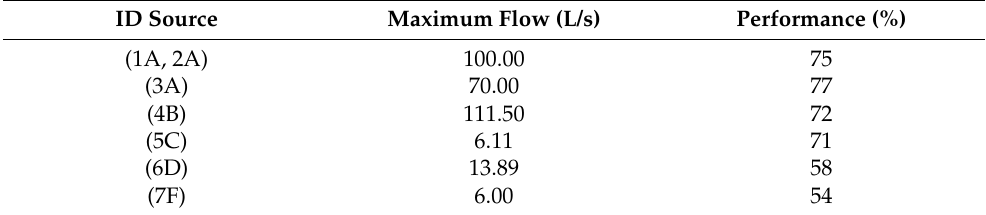
Table 4. Maximum flow and expected performance of the pumping stations of the Richmond network.